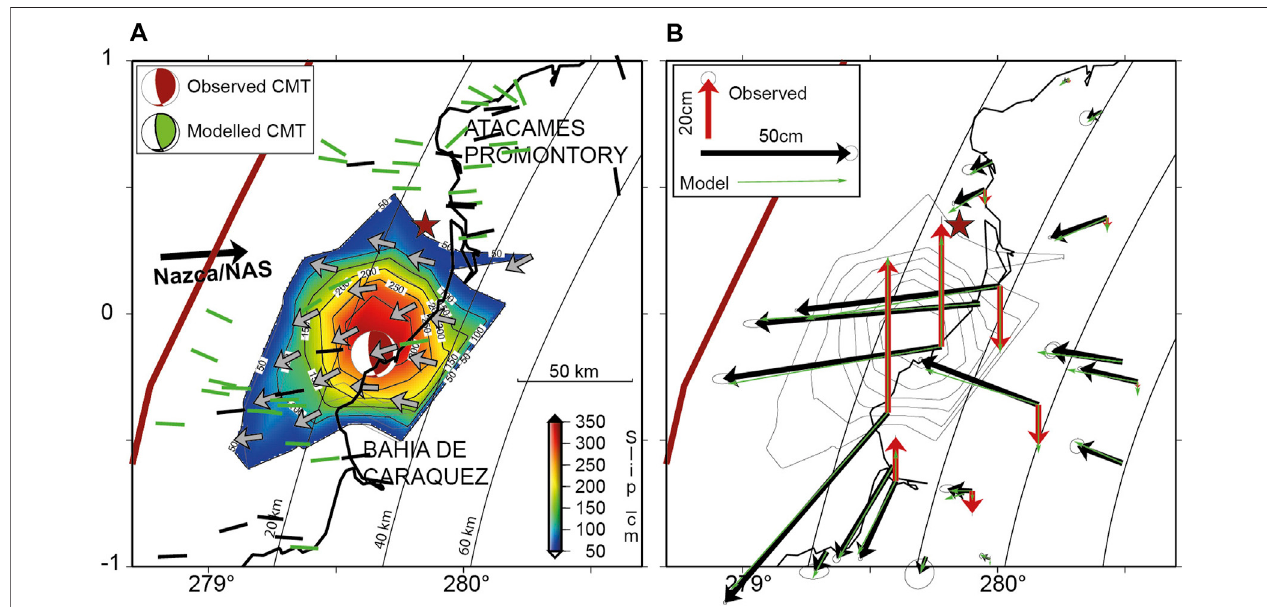
FIGURE 6 | GPS-derived seismic source of the 2016 Mw (cid:1) 7.8 Pedernales earthquake. (A) Seismic source distribution associated with the 2016 Mw (cid:1) 7.8 subduction earthquake derived from the jointinversionof horizontal and vertical GPSdata using Slab 2 megathrust geometry. Thecolor indicates the slipamplitude and the gray arrows the inverted slip rake directions at each source points that mesh the megathrust interface. Inverted slip rake directions are collinear with the gCMT slip rake directions of background seismicity (black bars) and aftershocks (green bars) that have preceded and followed the Mw (cid:1) 7.8 Pedernales earthquake (see the gCMT catalog in Supplementary Figure S1 ). These rake directions are also collinear with the relative Nazca/NAS plate convergence vector, suggesting no signi fi cant slip partitioning during that earthquake. The modeled focal mechanism (green beach-ball) is well consistent with the observed gCMT (red beach-ball). (B) Observed horizontal (black arrows) and vertical (red arrows) coseismic GPS displacements compared to the modeled displacements (green arrows) associated with the source model shown in A. Slip contours of the seismic sources are reported every 0.5 m.